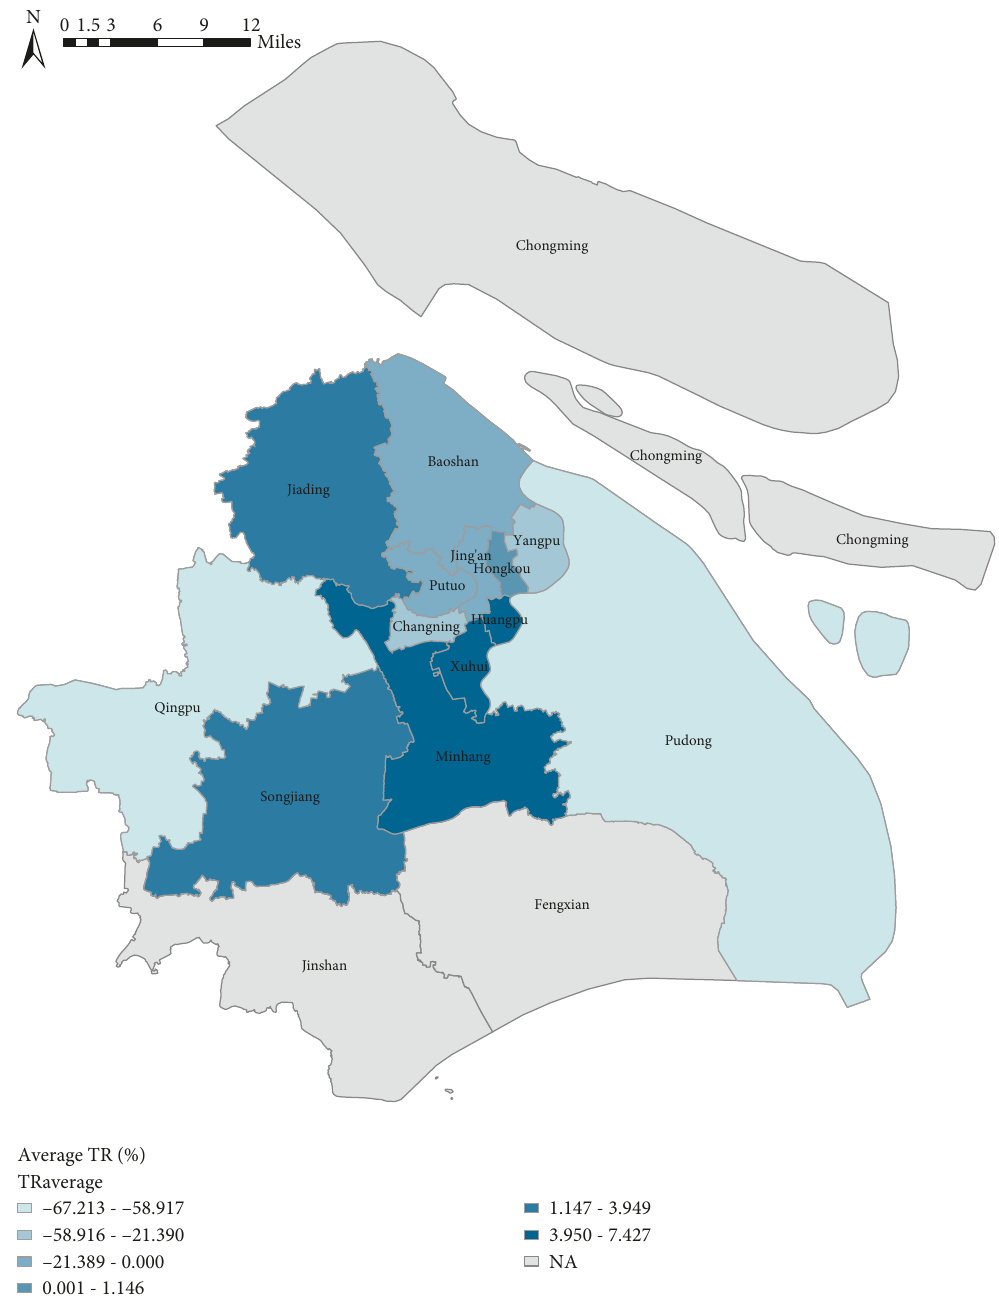
Figure 11: Evaluation of bike-sharing transfer services in different